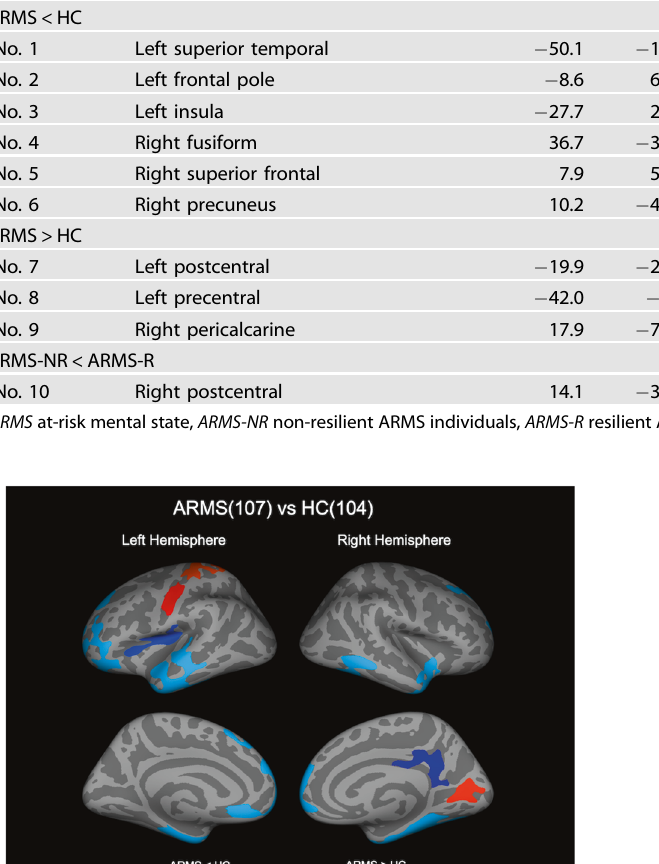
antipsychotic medication dosage, CAARMS or SOPS, and BACS subscores); although there were no signi fi cant differences